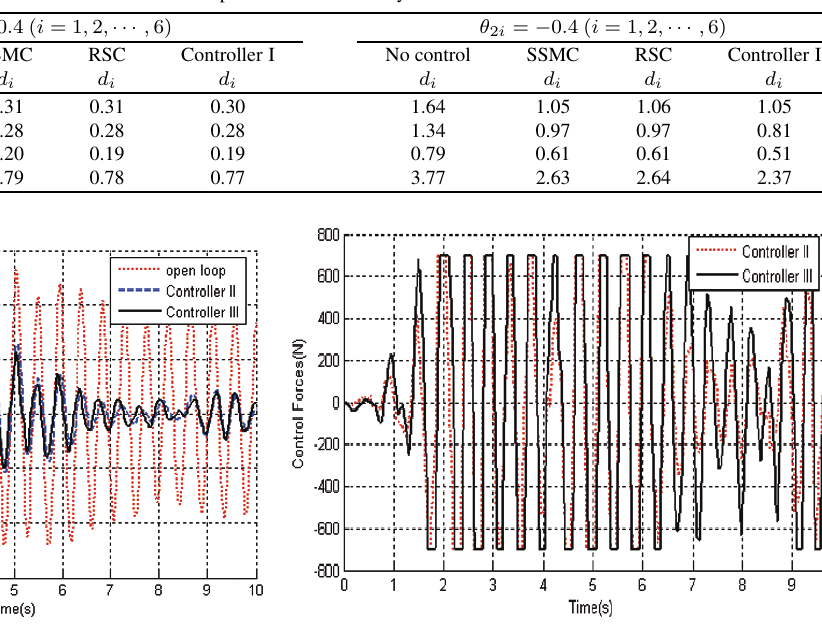
Fig. 3. Comparisons of the control forces of the two controllers.